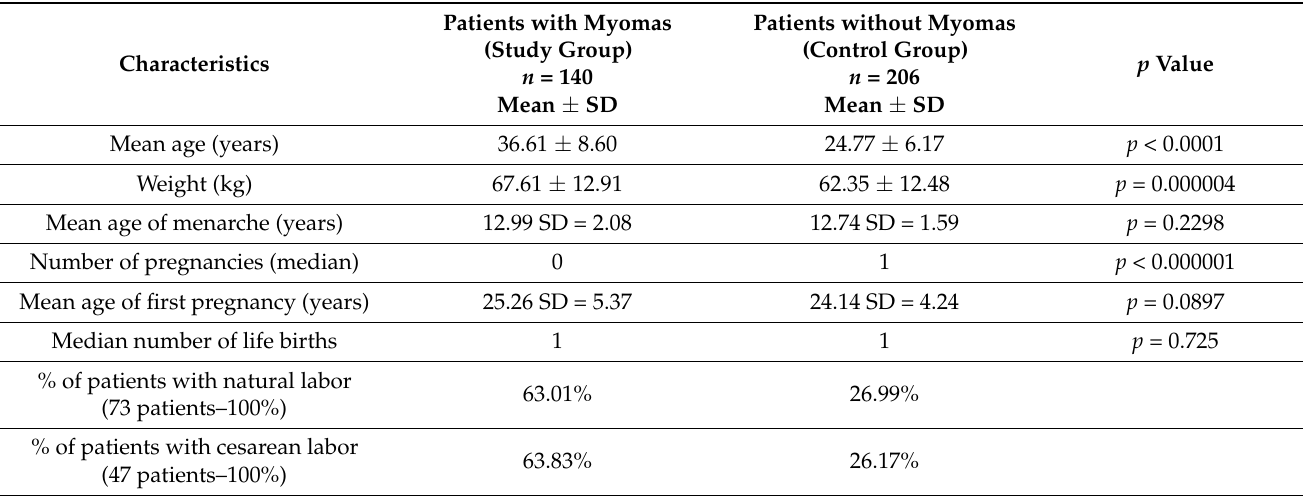
Table 1. Characteristics of studied population.